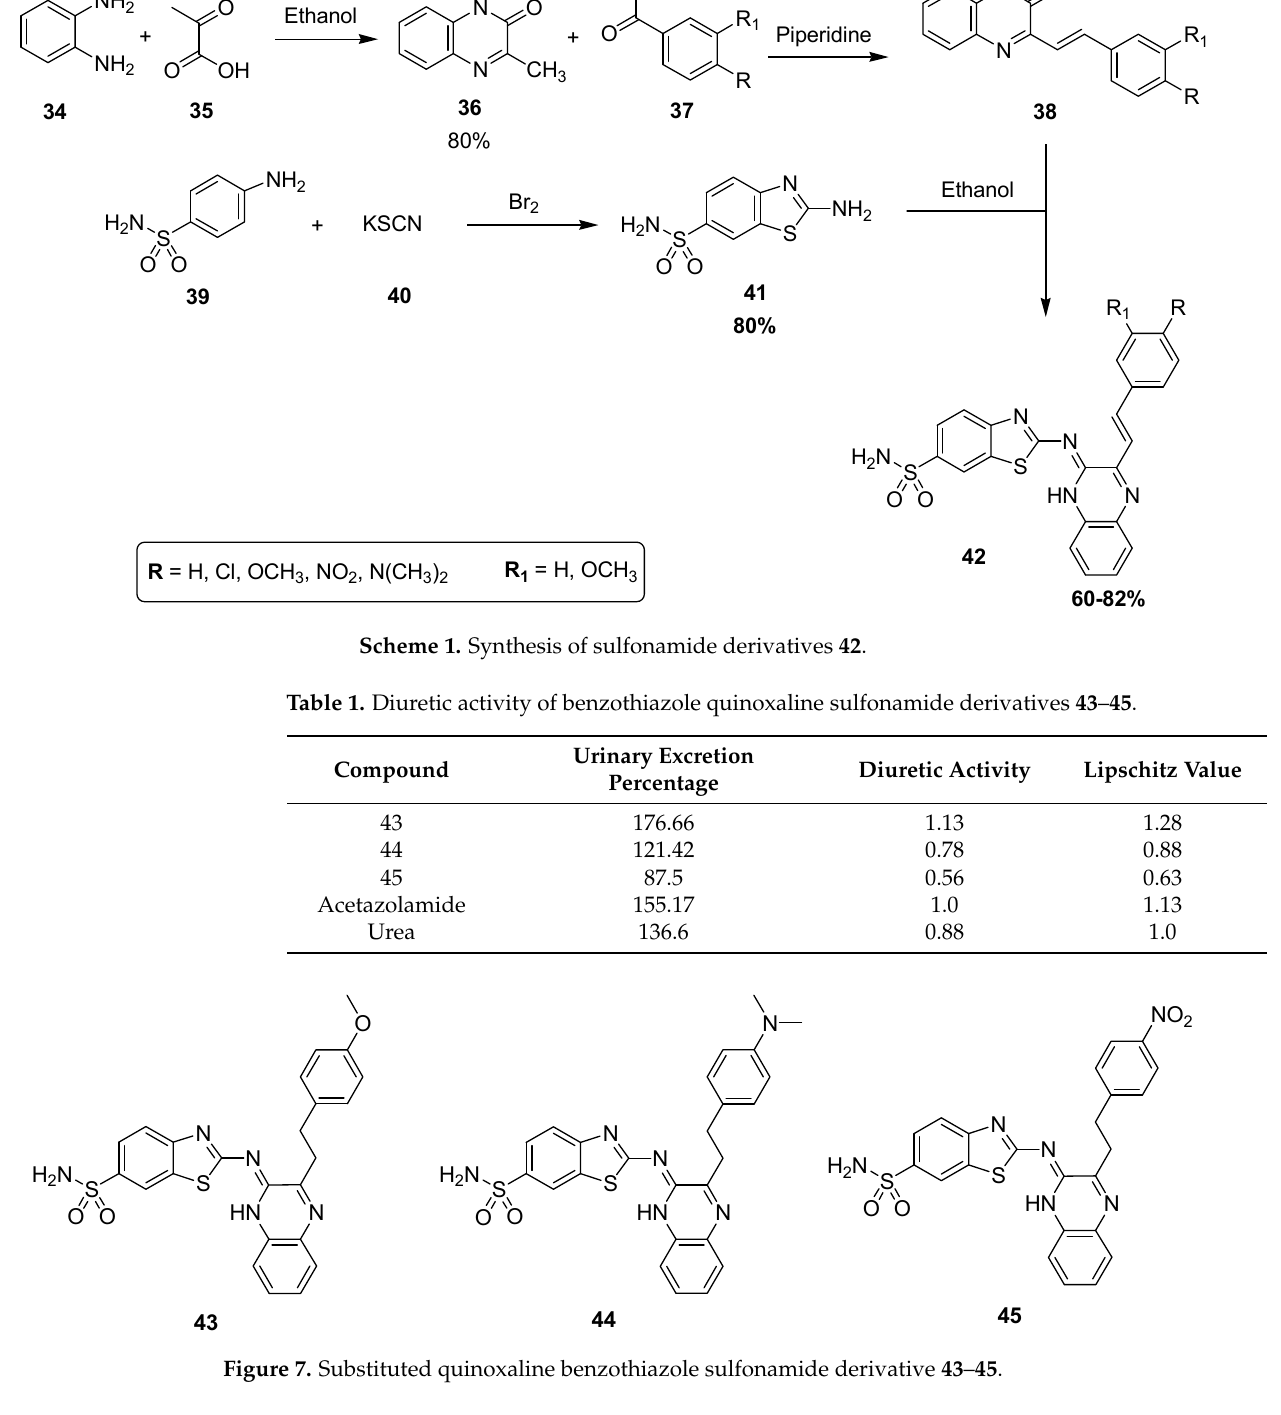
Figure 7. Substituted quinoxaline benzothiazole sulfonamide derivative 43–45.